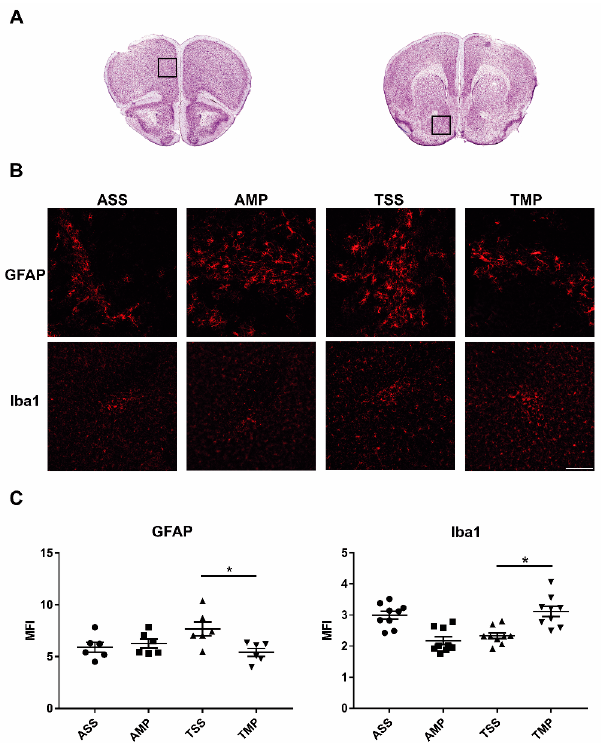
Figure 4. Analysis of brain GFAP and Iba-1 expression in exposed to toluene and non-exposed to toluene mice 24 h after the IN-MP administration. ( A ) Histological representation of analyzed areas. Squares points out areas in frontal cortex ( left ) and nucleus accumbens ( right ) which were analyzed. Images taken from “The mouse brain in stereotaxic coordinates” Reproduced from [30], OXFORD UNIV PRESS INC, 2020. ( B ) Representative images of GFAP and Iba-1 immunofluorescence stains. Scale bar represents 100 μ m. ( C ) The mean fluorescence intensity (MFI) of GFAP and Iba-1 in frontal cortex and nucleus accumbens were quantified using the Image J software. All results are showed as the mean ± standard error of groups values. * p < 0.05. ANOVA followed by Tukey’s test. Air + saline solution (ASS); air + methylprednisolone (AMP); toluene + saline solution (TSS); toluene + methylprednisolone (TMP).